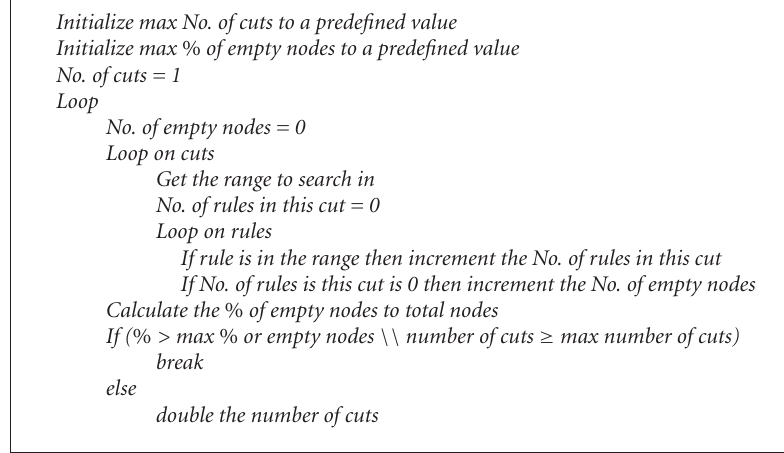
Algorithm 2: Get number of cuts for each selected dimension.